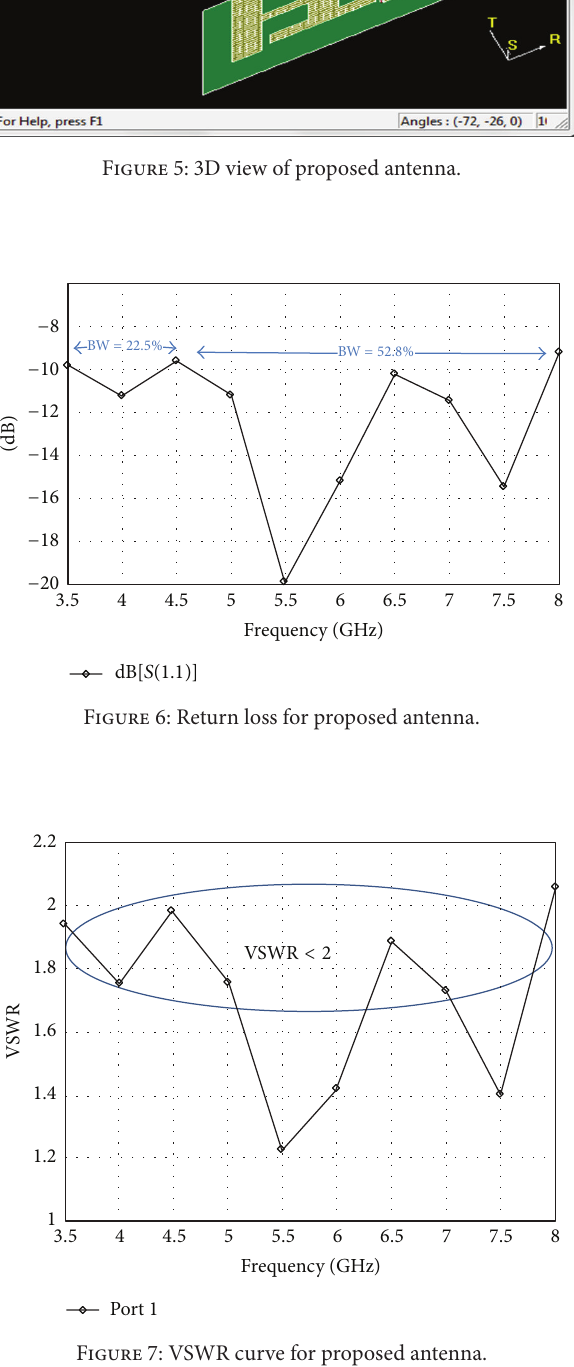
Figure 7: VSWR curve for proposed